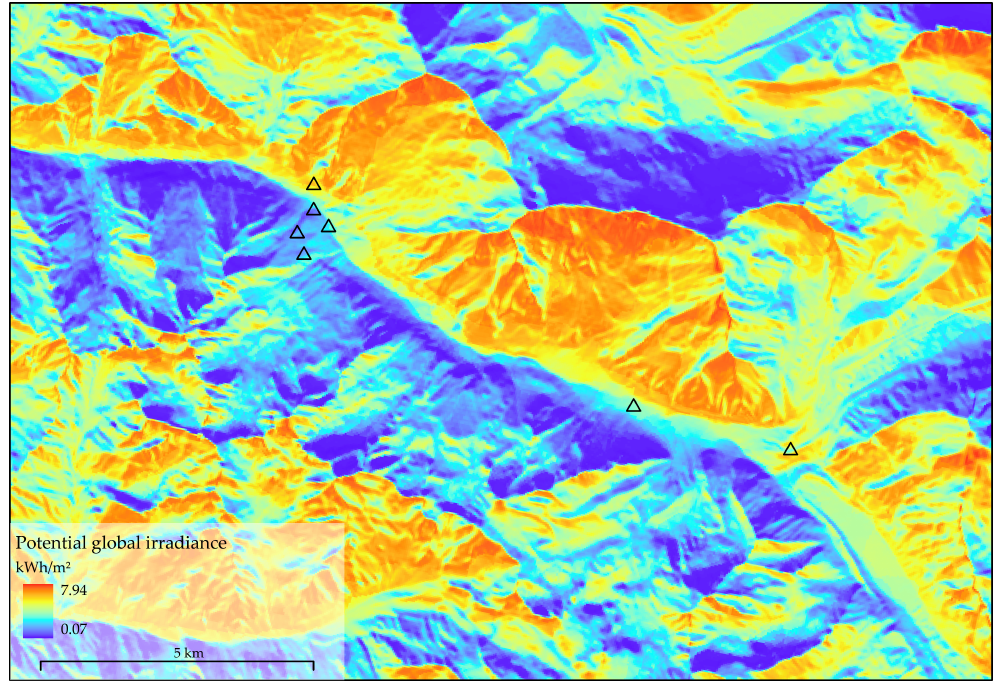
Figure 9. Potential incoming solar radiation over the study area on 22 November 2017. Calculated using ALOS (AW3D) by JAXA and SAGA-GIS